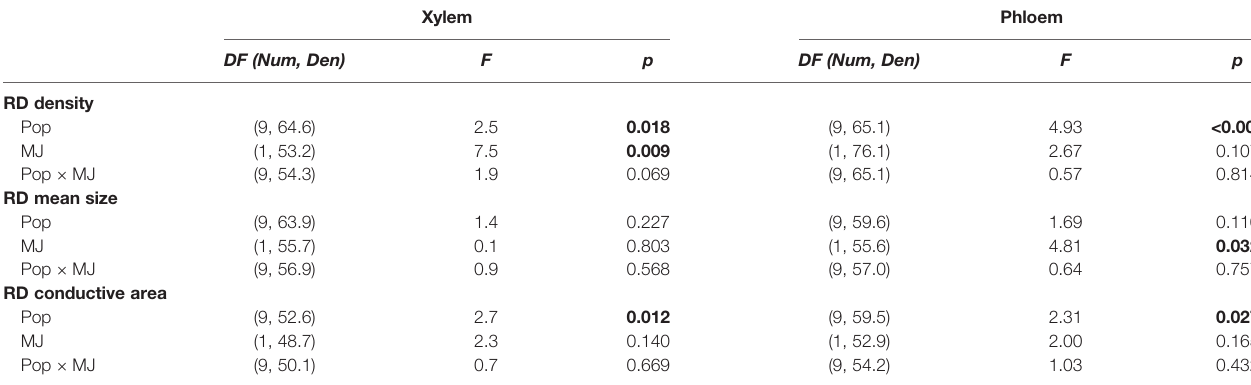
TABLE 2 | Summary of the mixed model testing the effects of Population (Pop), induction by methyl jasmonate (MJ), and their interaction (Pop × MJ) on resin duct density (RD density — RD/mm 2 ), mean size (RD mean size — mm 2 ) and relative conductive area (RD conductive area — %) in each tissue (xylem and phloem) of Pinus pinaster